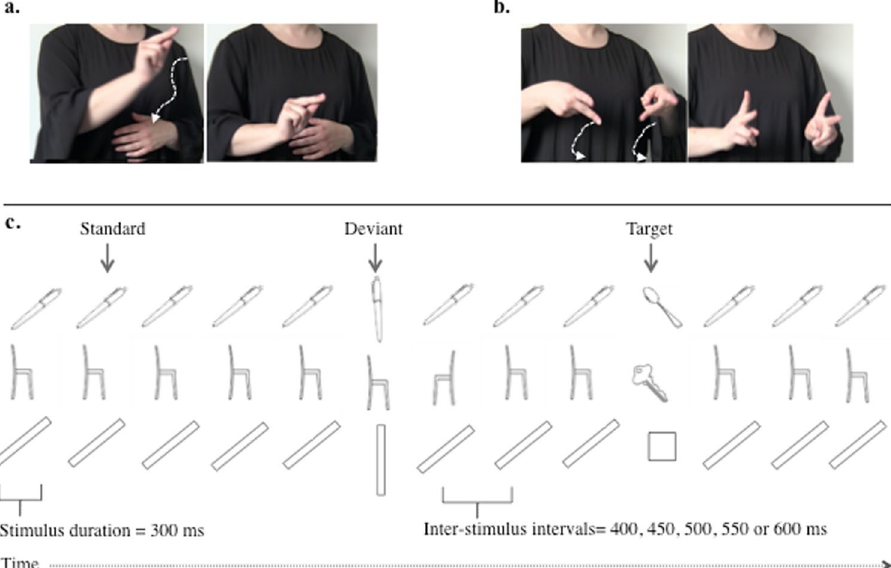
Figure 3. Illustration of the signs pen (Panel a) and chair (Panel b) in Italian Sign Language. Two snapshots were taken for each sign – one at the beginning, the other at the end of sign production. Panel ( c ) Sequence of stimuli of the three-stimulus oddball task used in Experiment 2 (pictures used available at https://osf.io/ y4pb9/. Stimuli appeared in rapid succession, one at a time. Each row presents the stimuli tested in one of the experimental conditions. Participants responded only to the targets. The other stimuli in the sequence (standard and deviant) represented the same object in different orientations. Analyses focused on the difference between standard and deviant trials. In each sequence, the standard appeared with a far higher probability (0.80) than the deviant (0.15) and the target (0.05). The orientation of pen was either consistent with the orientation of pen in the sign pen from a signer perspective, or differed from it. The orientations of bar were the same as pen. The orientations of chair had no correspondence with the sign chair and created mirror reversed images of